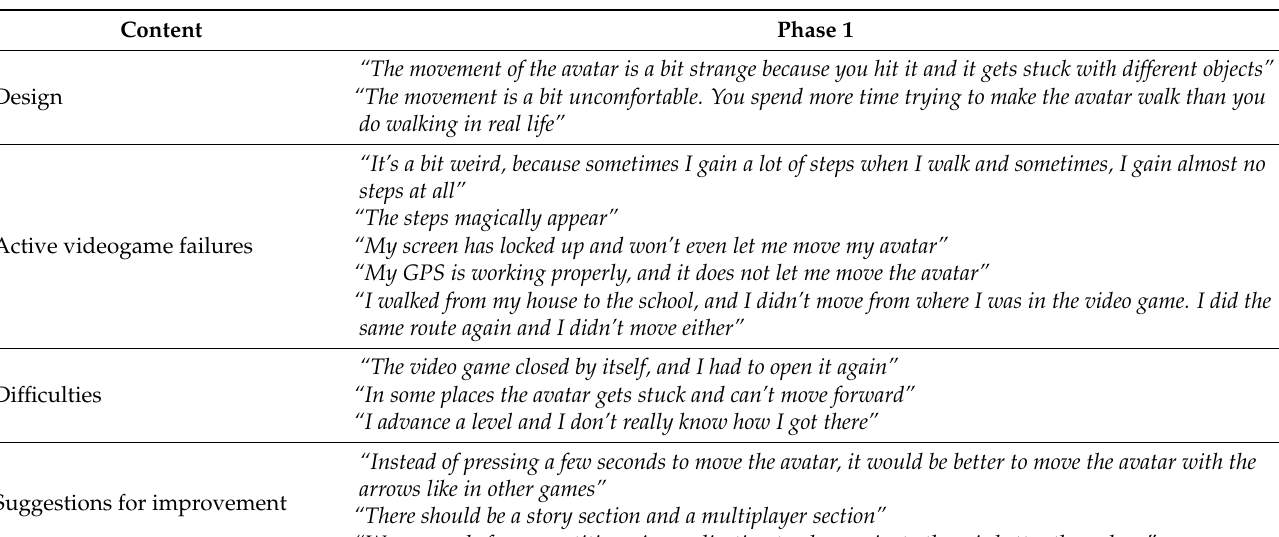
Table 3. Adolescents’ perceptions about the app Mystic School in phase